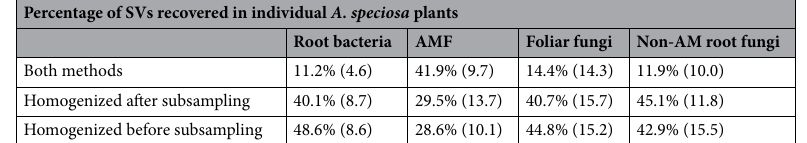
Table 2. Mean and standard deviation of the percent of bacterial and fungal sequence variants (SVs) recovered from individual milkweed plants using two different subsampling strategies (subsampling before homogenization and subsampling after homogenization of tissue).